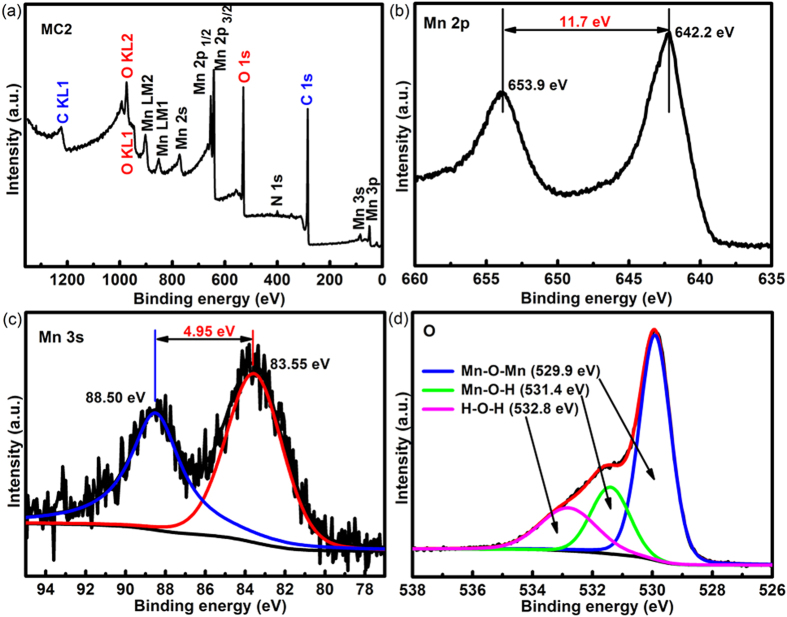
XPS spectra of MC2 composites (a) elements composition, binding energy separation of (b) Mn 2p and (c) Mn 3 s, (d) the intensities of Mn-O-Mn and Mn-OH.